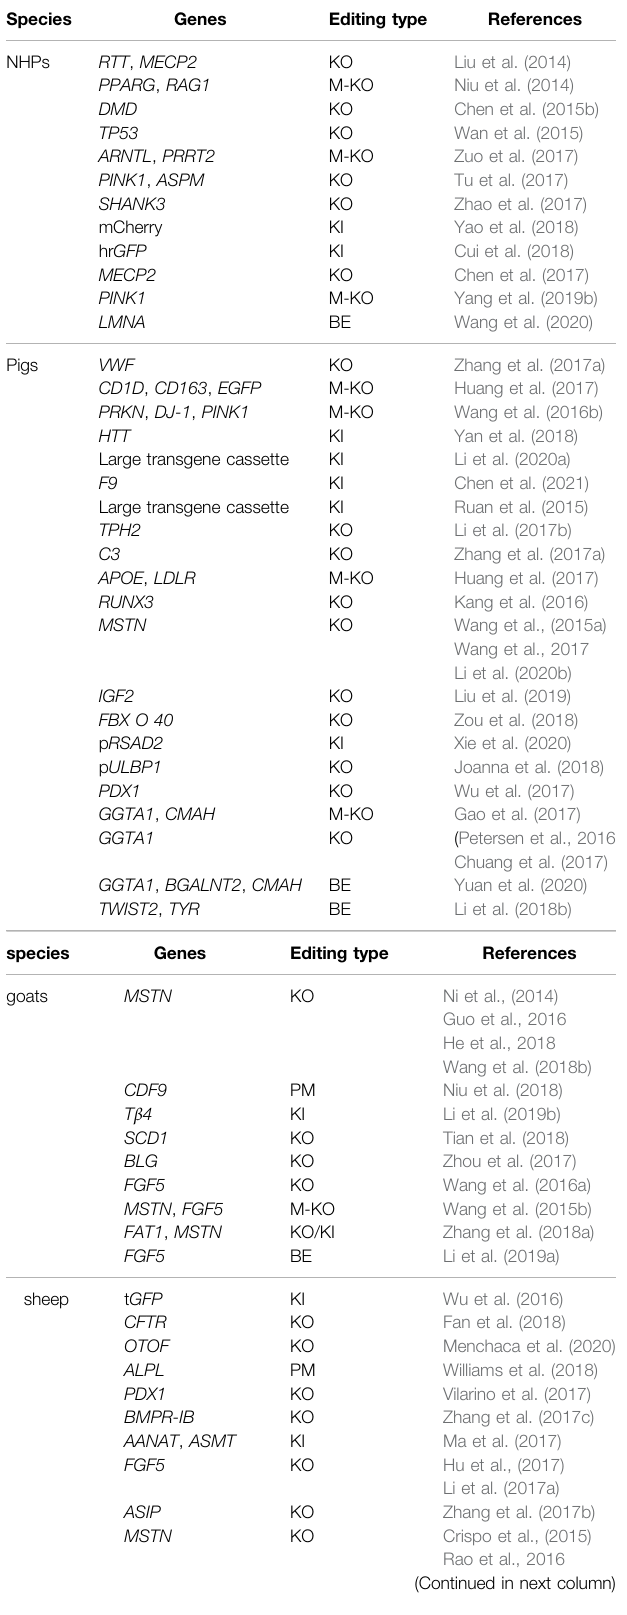
TABLE 1 | Examples of genome-edited large animals described in this